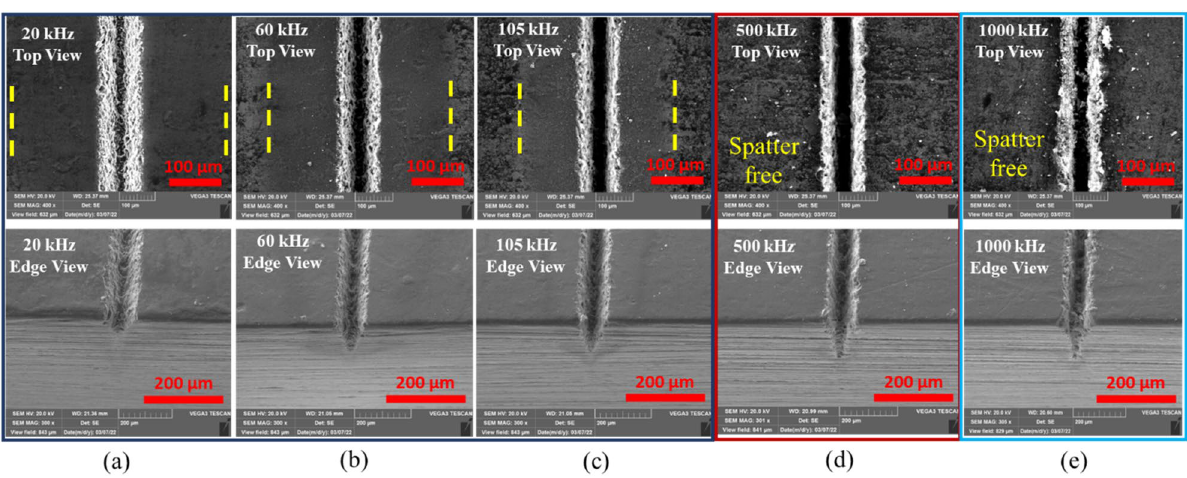
Figure 14. SEM images showing physical morphology with repetition rate at 200 ns. ( a ) 20 kHz, ( b ) 60 kHz, ( c ) 105 kHz, ( d ) 500 kHz and ( e ) 1000 kHz [Fixed: 20W, 100 mm/s, 1 pass and 200